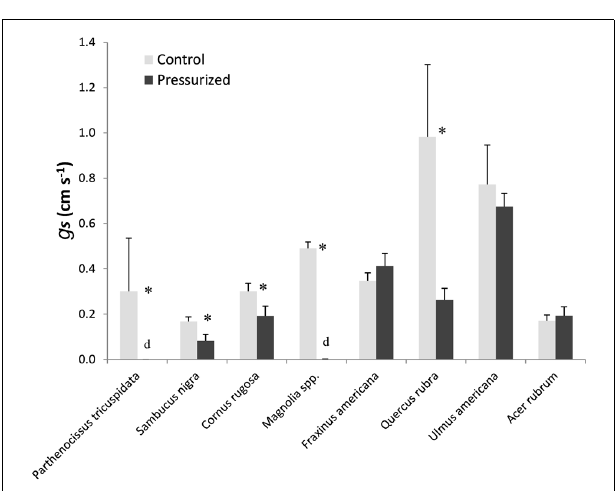
FIGURE 7 | Changes in petiole specific hydraulic conductivity ( k pet ) measured after applying (cid:3) P pit treatments of 3.0 (open symbols) and 5.0 MPa (closed symbols) of nitrogen gas through excised side branches located about 1-m upstream of the petioles that were used for k pet analysis . Data were compared to non-pressurized controls (dashed lines represent the averages and dotted lines represent the 95% C.I. of the